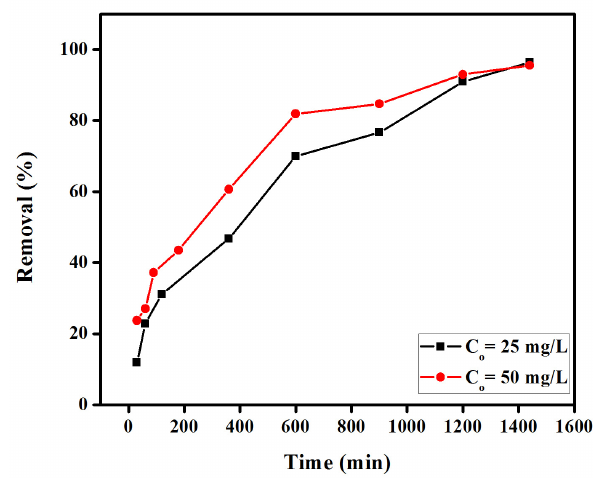
Figure 2. Effect of contact time on the removal (%) of congo red using anion exchange membrane